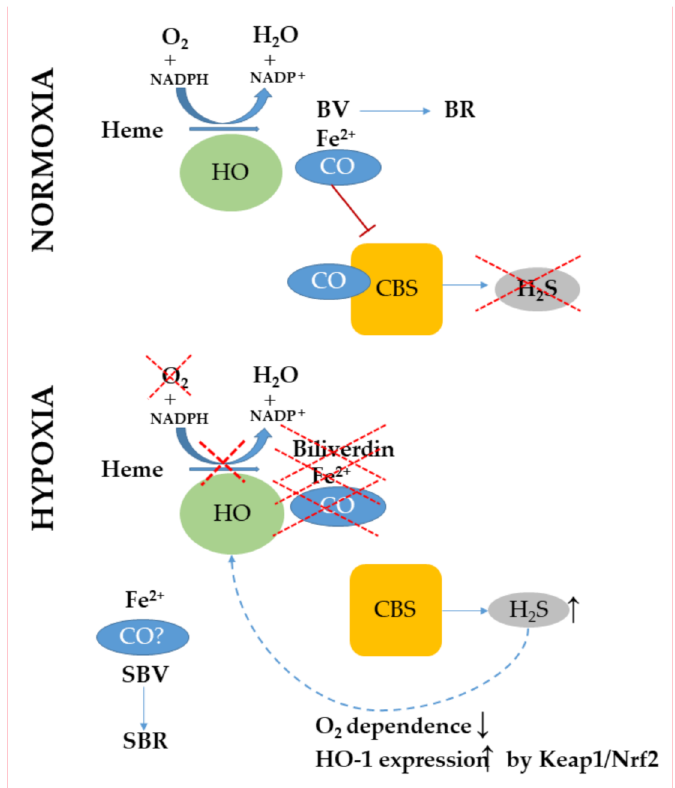
Figure 5. Interaction between the heme oxygenase/carbon monoxide and cystathionine beta synthase/H 2 S systems in vascular pathologies. In a normoxic environment, sufficient oxygen supply enables heme degradation by heme oxygenases (HOs) forming iron, biliverdin (BV), and carbon monoxide (CO), the latter of which inhibits cystathionine β -synthase (CBS) activity, leading to decreased hydrogen sulfide (H 2 S) production. BV is then formed to bilirubin (BR) by biliverdin reductase. In hypoxia, heme catabolism and CO generation by HOs is disturbed due to the limited oxygen availability, resulting in the derepression of CBS activity with concomittant H 2 S synthesis. H 2 S decreases the oxygen dependence of HOs, which enables heme catabolism leading to iron and sulfo-BV formation, the latter of which is converted to sulfo-BR. It is currently unknown whether CO is formed during this reaction. Besides, H 2 S might also increase HO-1 expression via the sulfenylation of Keap-1 that releases Nrf2, which induces Nrf2-regulated gene expression, including HO-1. BV: biliverdin; BR: bilirubin; CO: carbon monoxide; CBS: cystathionine β -synthase; HO: heme oxygenase; Keap-1: Kelch-like ECH-associated protein 1; Nrf2: nuclear factor erythroid 2-related factor 2; SBV: sulfur-containing biliverdin; SBR: sulfur-containing bilirubin; ↑ : increase; ↓ : decrease; red X: